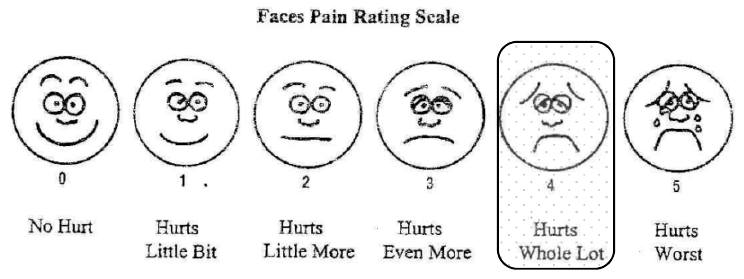
Figure A2. Level of pain.